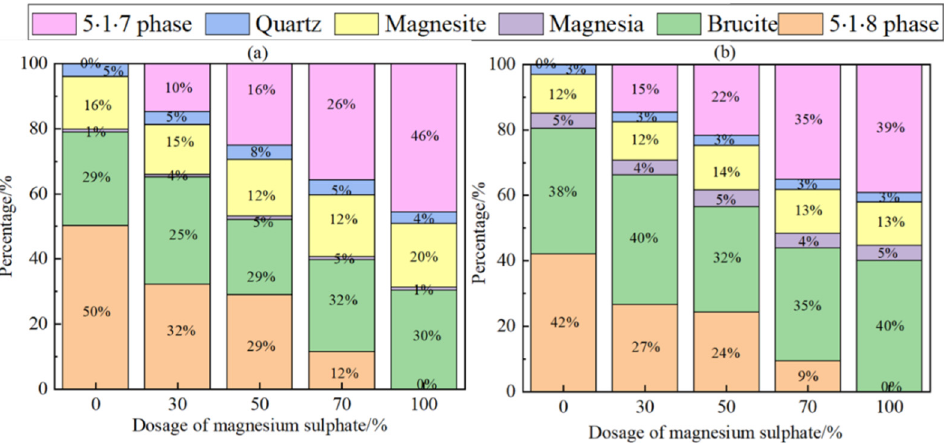
Figure 6. The content of phases in cement with different mass fractions of MgSO 4 ( a ) Air curing for 28 days; ( b ) Water immersion for 28 days.